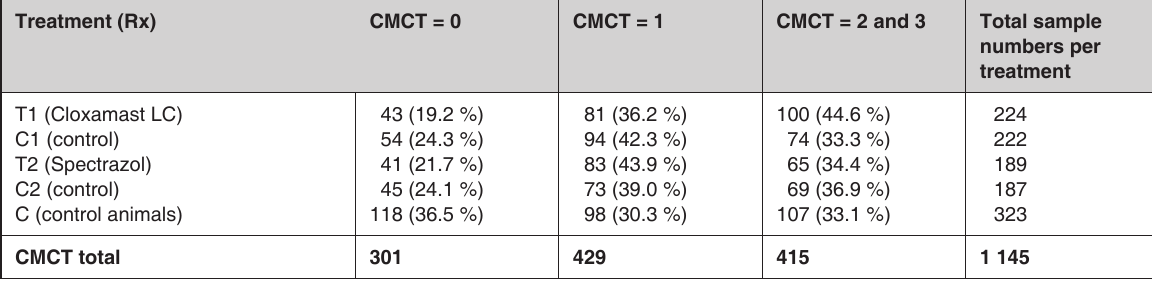
The Chi-square test performed on the data in the table above was highly significant ( χ 2 = 33.43; P < 0.001; degrees of freedom = 8) TABLE 6 California Milk Cell Test (CMCT) ratings ( %), for right and left udder halves for treatment and control groups of milk goats Treatment (Rx)